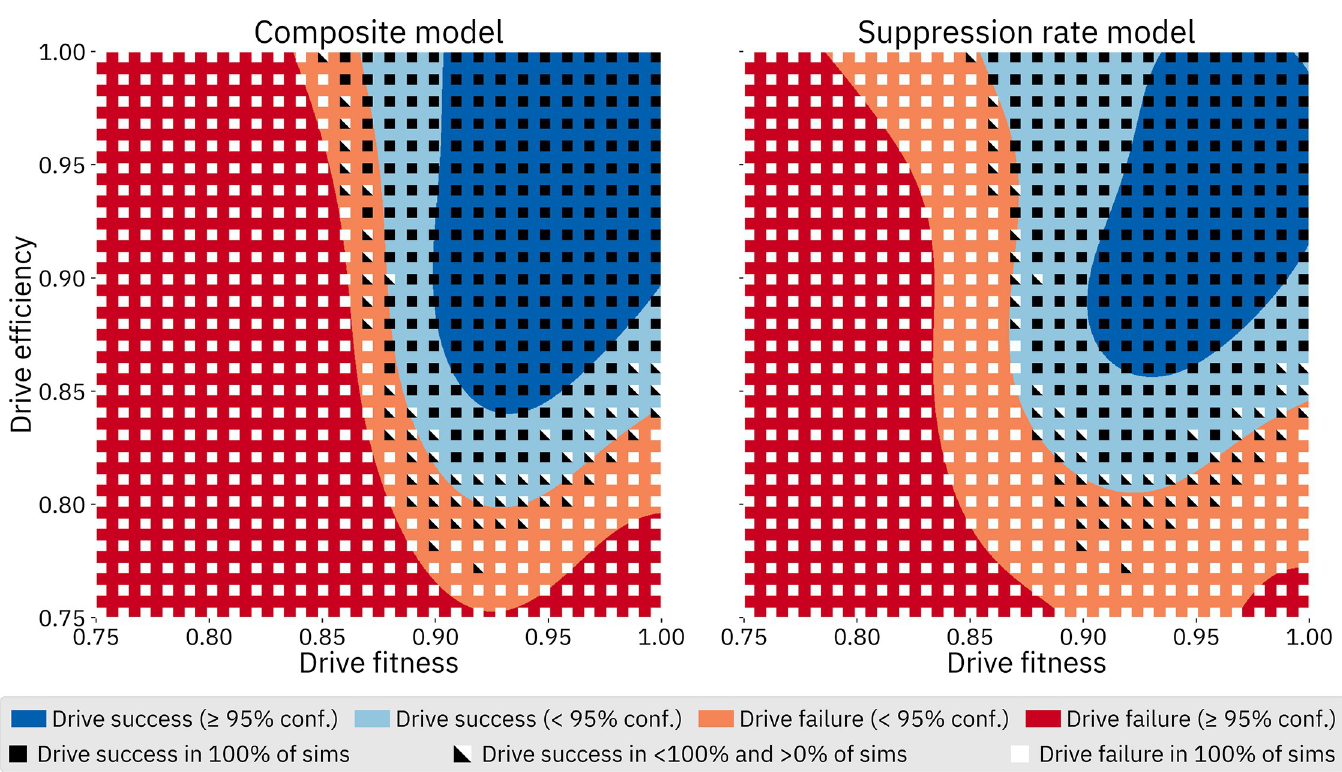
Fig 7. Model comparison, female fertility homing drive without resistance. For this comparison, drive fitness and efficiency were varied while other parameters were kept at default values. A 1000 by 1000 array of queries was made to both GP models; color indicates model predictions of drive success or failure, as well as confidence. Black and white square dots show results from simulations using the underlying model. Each square dot denotes the result of twenty simulations performed at each point. This overlay serves as a visual validation of the GP framework; the actual model behavior in this parameter range (i.e., how drive success depends on model parameters) is discussed in more detail in the “Selected Model Outcomes” section below. See S2–S5 Figs for similar plots for the other